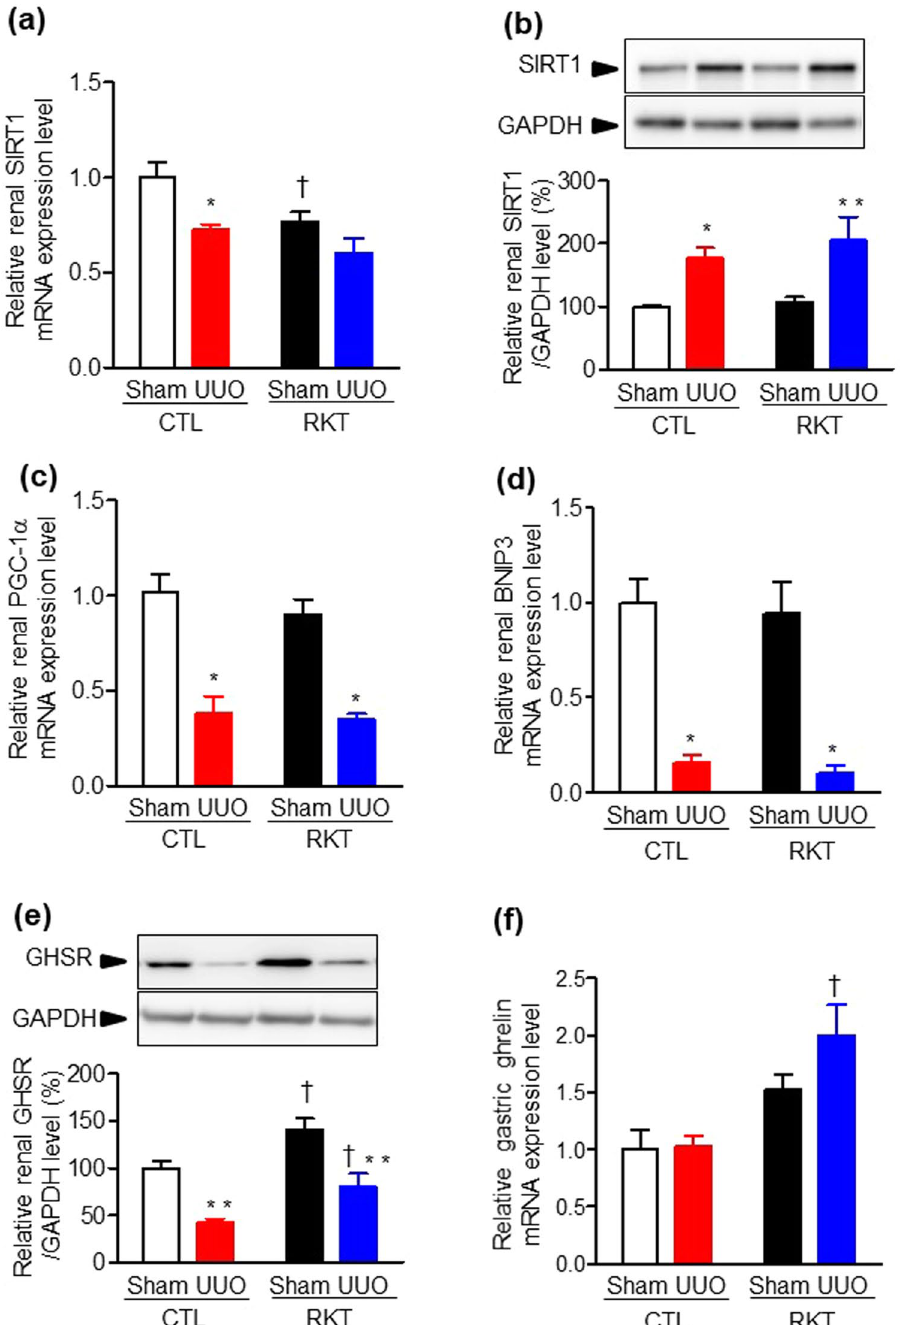
Figure 4. Effects of Rikkunshito treatment on renal level of SIRT1, mitochondrial function-related genes, GHSR, and gastric ghrelin levels in sham- and UUO-operated mice. Quantitative analysis of mRNA levels of ( a ) sirtuin 1 (SIRT1), ( c ) peroxisome proliferator-activated receptor- γ coactivator 1 α (PGC-1 α ), ( d ) Bcl-2/ adenovirus E1B interacting protein 3 (BNIP3) in kidneys, and ( f ) ghrelin in stomach of sham- and UUO- operated mice fed a standard diet and a diet containing Rikkunshito. Immunoblot analysis of ( b ) SIRT1 and ( e ) GHSR protein levels in kidneys of sham- and UUO-operated mice fed a standard diet and a diet containing Rikkunshito. Values are expressed as the mean ± SE ( a – e , n = 6 in each group. f , n = 7–8 in each group). * P < 0.05, ** P < 0.01 vs sham-operated group. † P < 0.05 vs CTL group. Differences between sham and UUO mice within each diet and between CTL and RKT within each surgery were analysed by two-factor ANOVA with Bonferroni’s post-test. CTL, control standard diet; RKT, diet containing Rikkunshito; UUO, unilateral ureteral